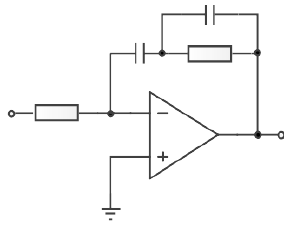
Figure 12. The active proportion-integration